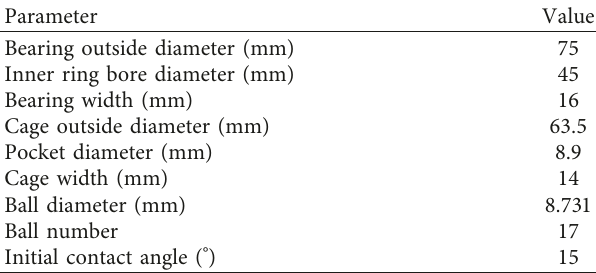
Table 2: Structural parameters of the ceramic